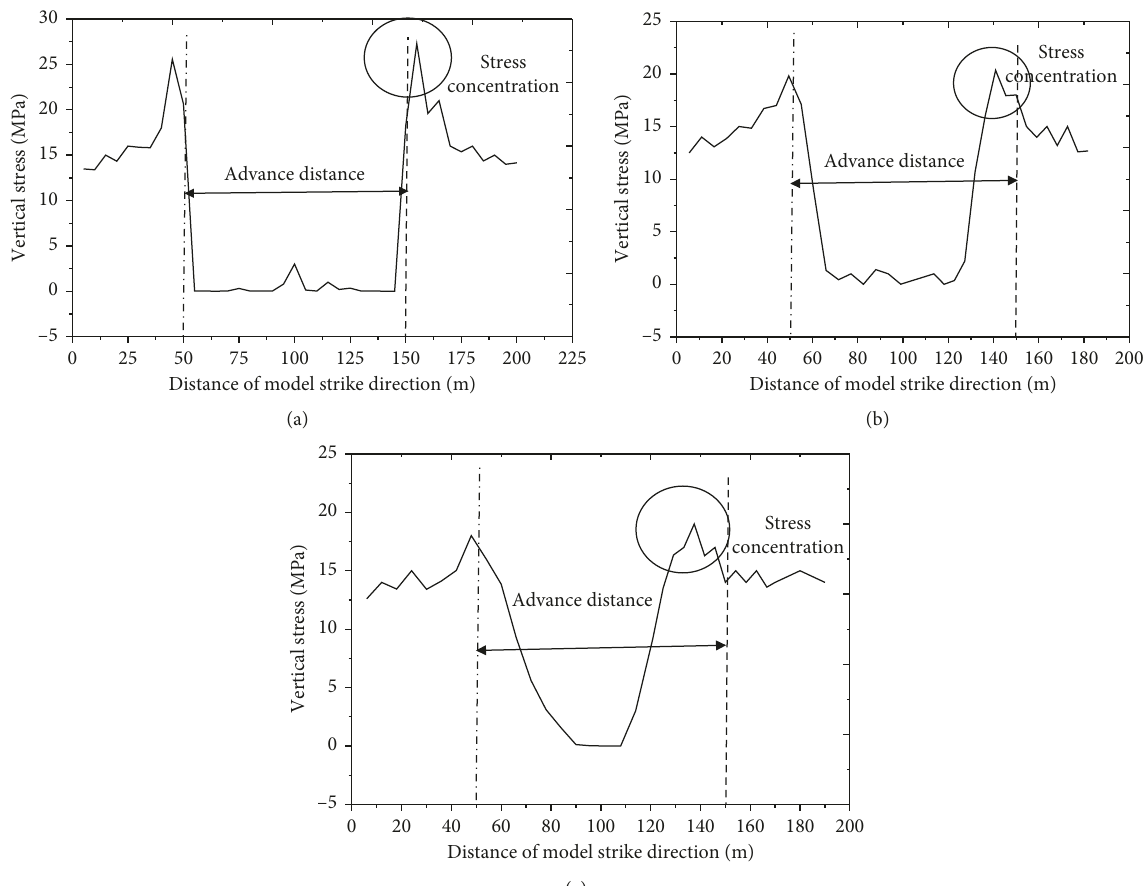
Figure 18: The stress distribution of the rock layers at different distances from the roof to coal seam: (a) 0m (in coal seam); (b) 15m; (c)